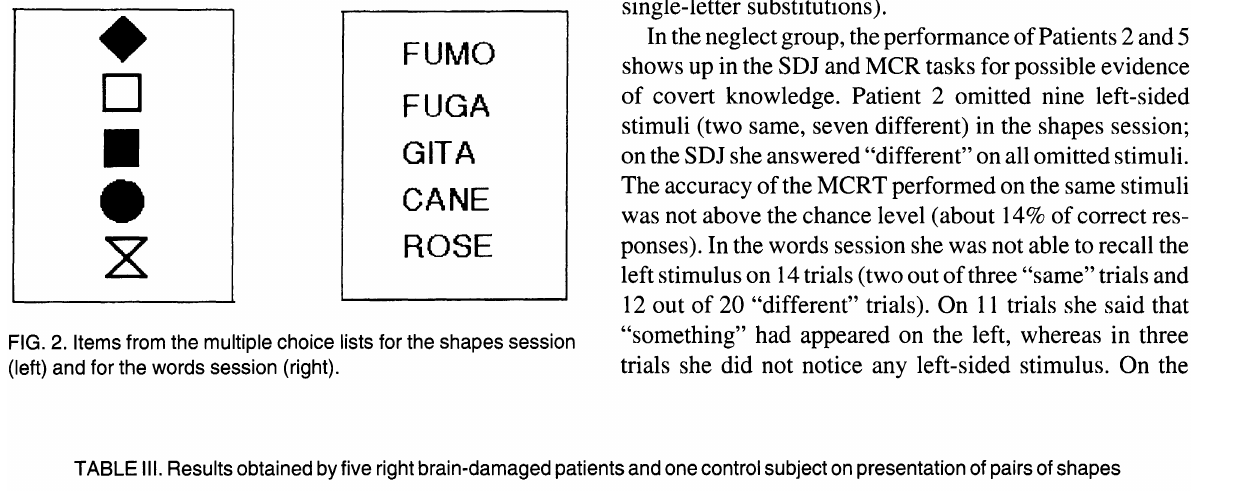
TABLE III. Results obtained by five right brain-damaged patients and one control subject on presentation of pairs of shapes